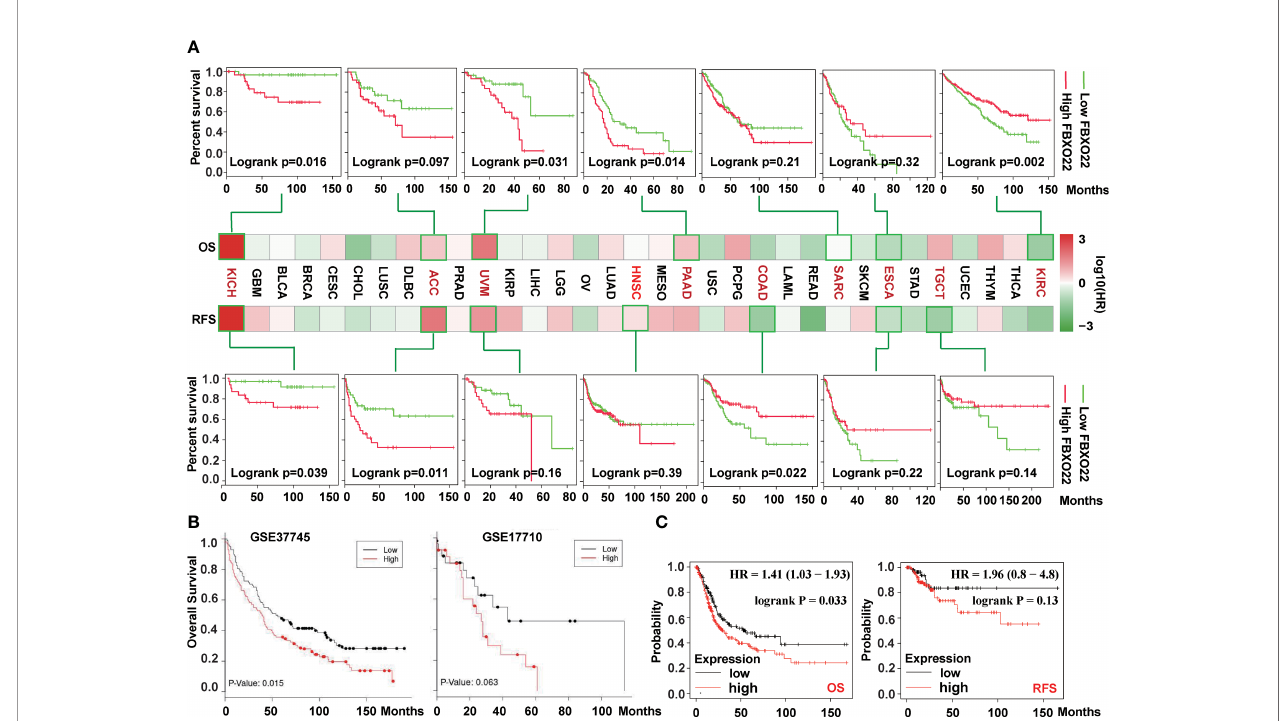
FIGURE 2 | Correlation between survival and FBXO22 gene expression in different cancer types. (A) Correlation between FBXO22 gene expression and overall survival/disease-free survival in different tumor types in TCGA assessed using GEPIA2. (B) Correlation between FBXO22 expression and overall survival in the lung cancer datasets GSE37745 and GSE17710 from the GEO database assessed using LUNG CANCER EXPLORER. (C) Correlation between FBXO22 expression and overall and disease-free survival in pan-cancer using Kaplan-Meier